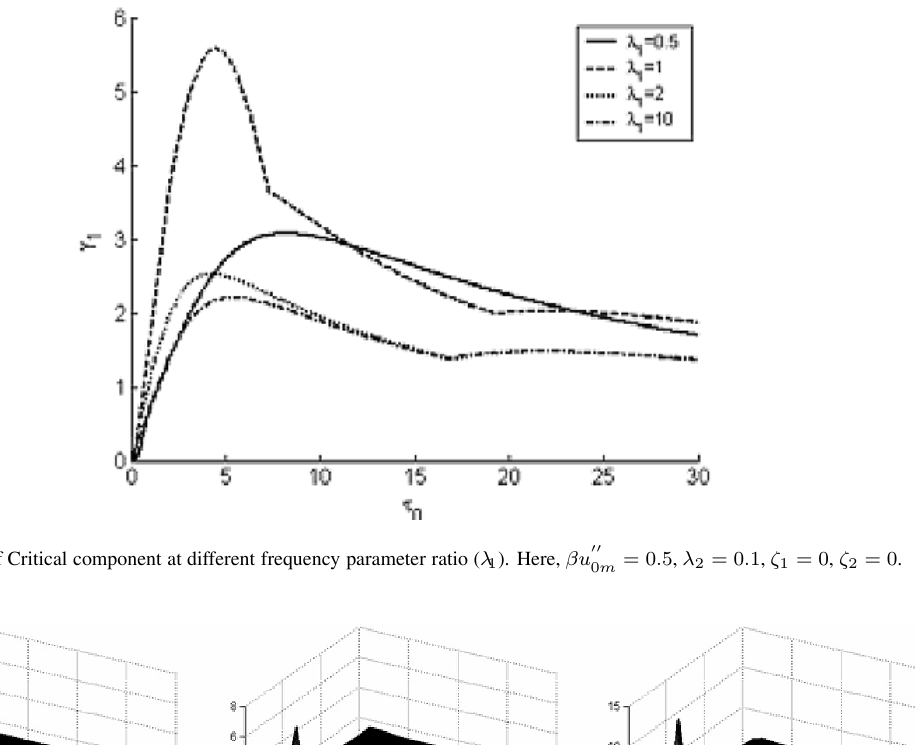
Fig. 4. SRS of Critical component at different frequency parameter ratio ( λ 1 ). Here, βu